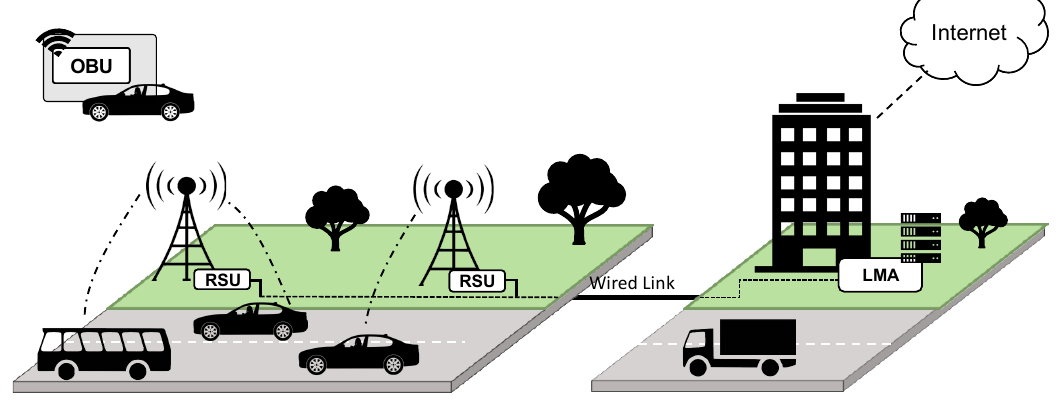
Figure 2. Simple representation of a N-PMIPv6 based VANET, illustrating only its main